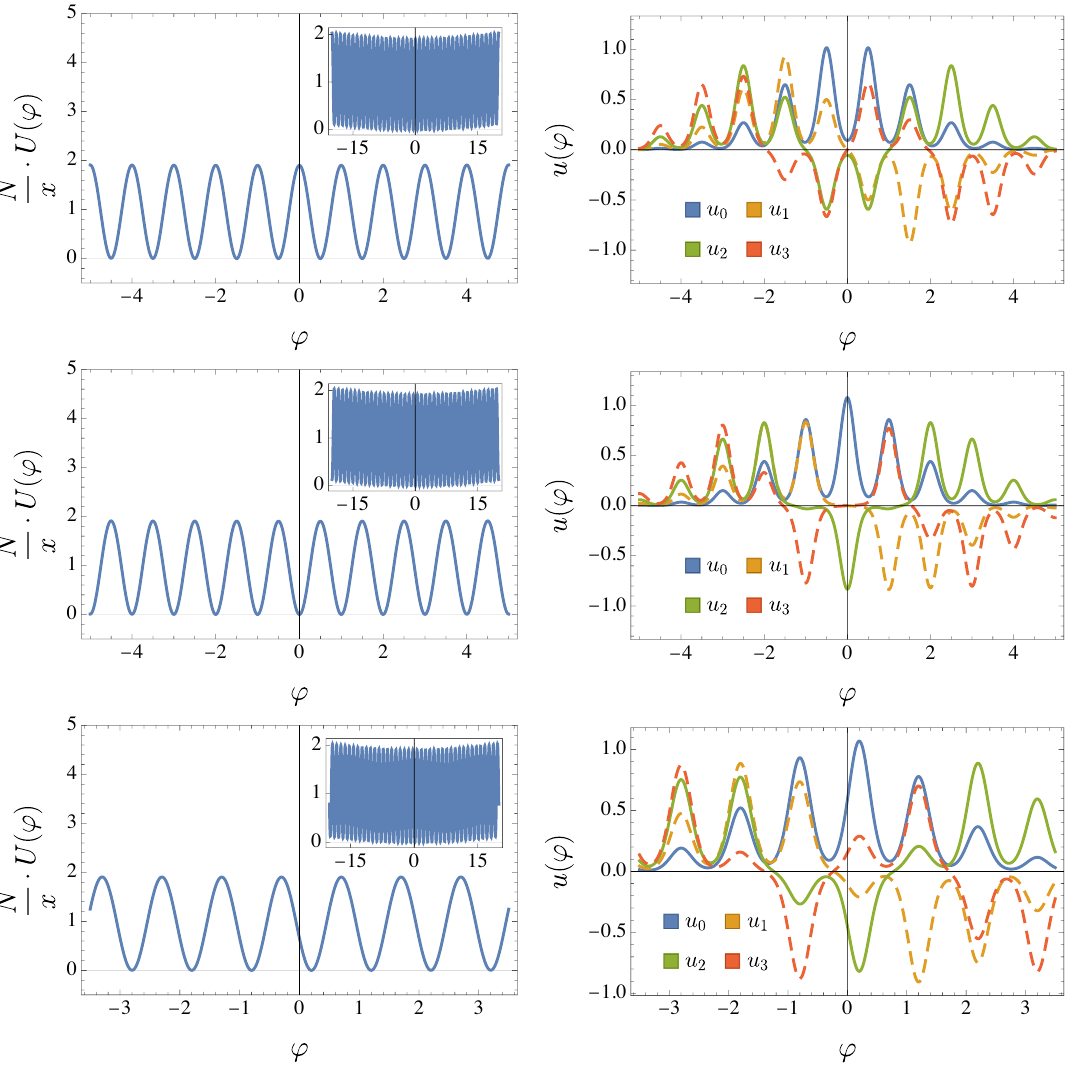
Figure 9. The (dimensionless) effective quantum mechanical potential in (4.6) and the (dimension- less) wavefunctions of the lowest two Hamiltonian eigenstates for m/g = 50 , mL = 4 , a multiwell regime example, on N = 10 lattice. Upper panel: α = 0 . 5 , middle panel: α = 0 , lower panel: α = 0 . 2 . The wavefunctions u 0 , u 1 , u 2 , u 3 are respectively the ones in ϕ -representation for the ground, the first-, the second-, and the third-excited